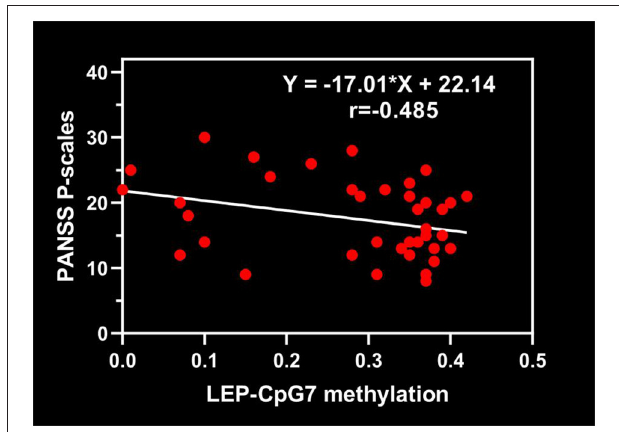
FIGURE 3 | Multiple stepwise regression between LEP -CpG7 methylation and PANSS Positive subscore.